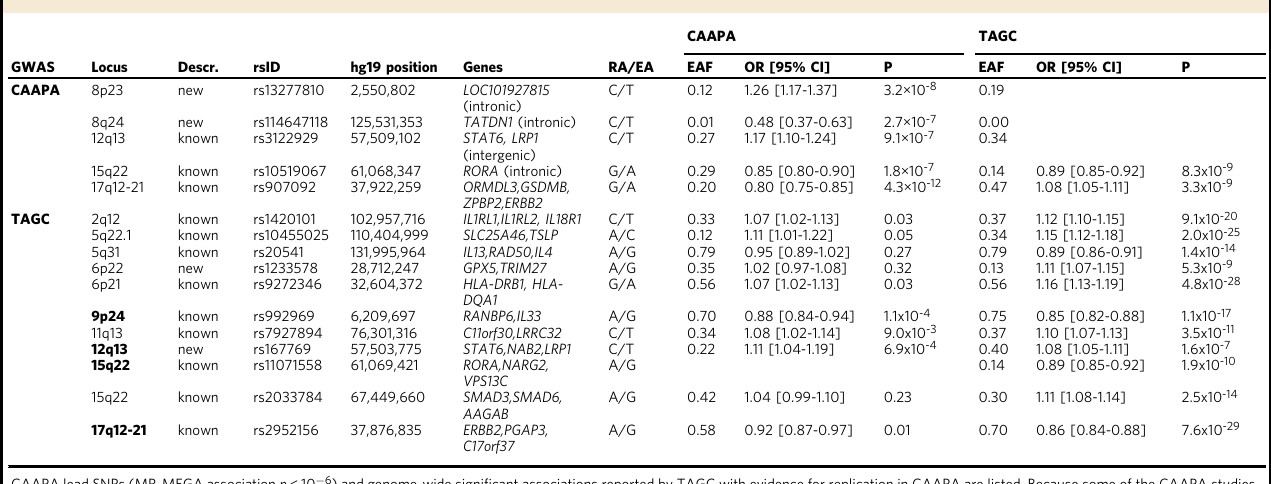
Table 2 Lead SNP